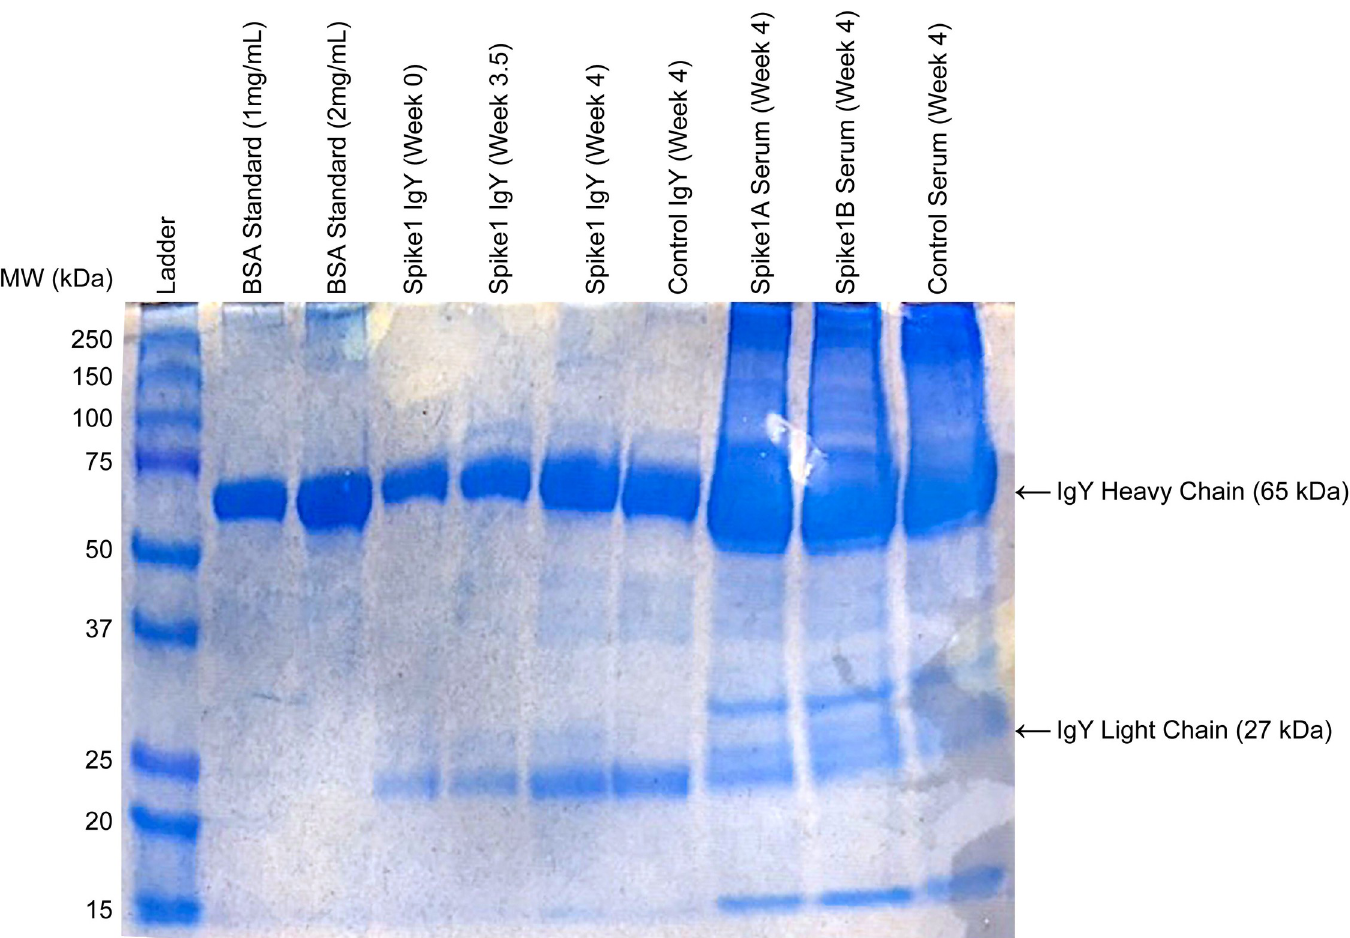
Fig 1. SDS-PAGE analysis of SARS-CoV-2 S1 spike-specific IgY carried out under reducing conditions. Lanes 4–7 show IgY extracted from yolks at indicated time intervals; lanes 8–10 show IgY in serum at Week 4; “A” and “B” indicate serum from each hen. IgY heavy and light chains show characteristic bands at 65 and 27 kDa, respectively. “Control” indicates material from unimmunized